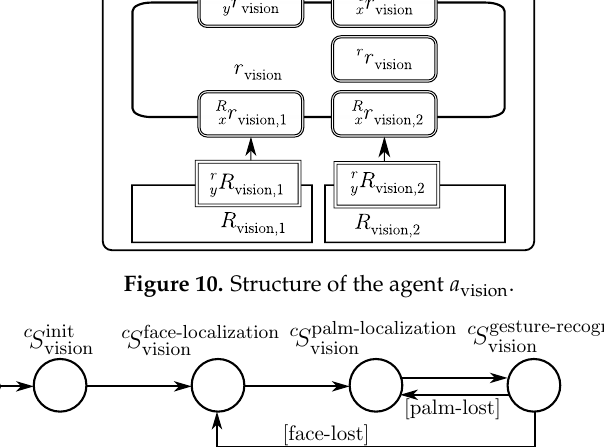
of the of agent a vision ; square vision